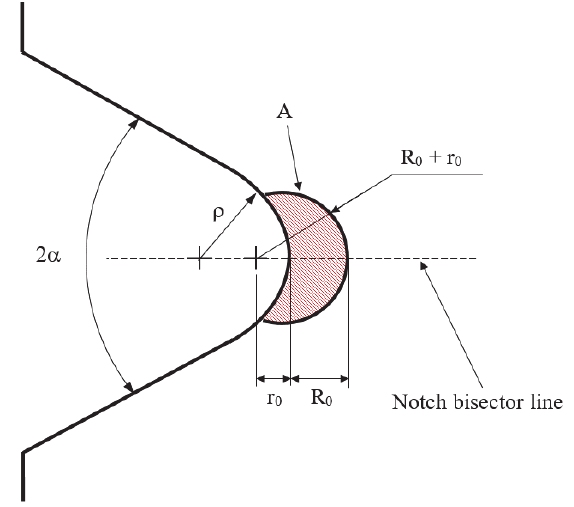
Figure 2: Control volume for specimens weakened by rounded V-notches